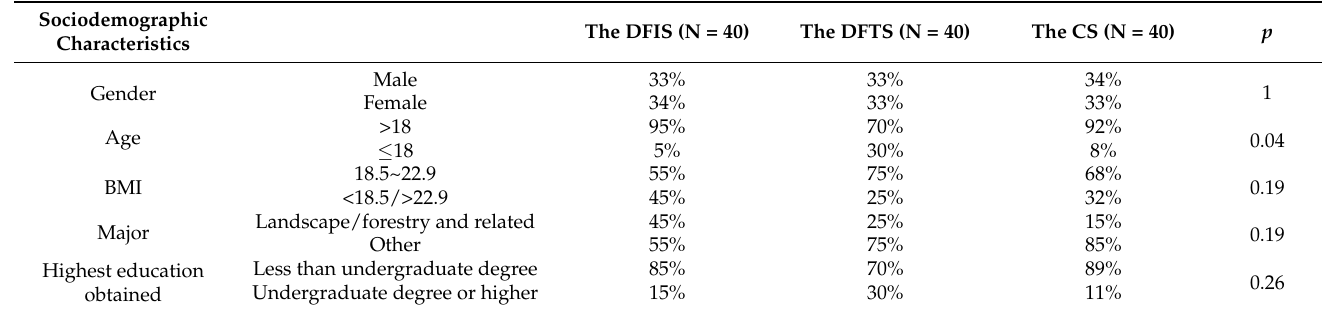
Table A1. Descriptive analysis for the